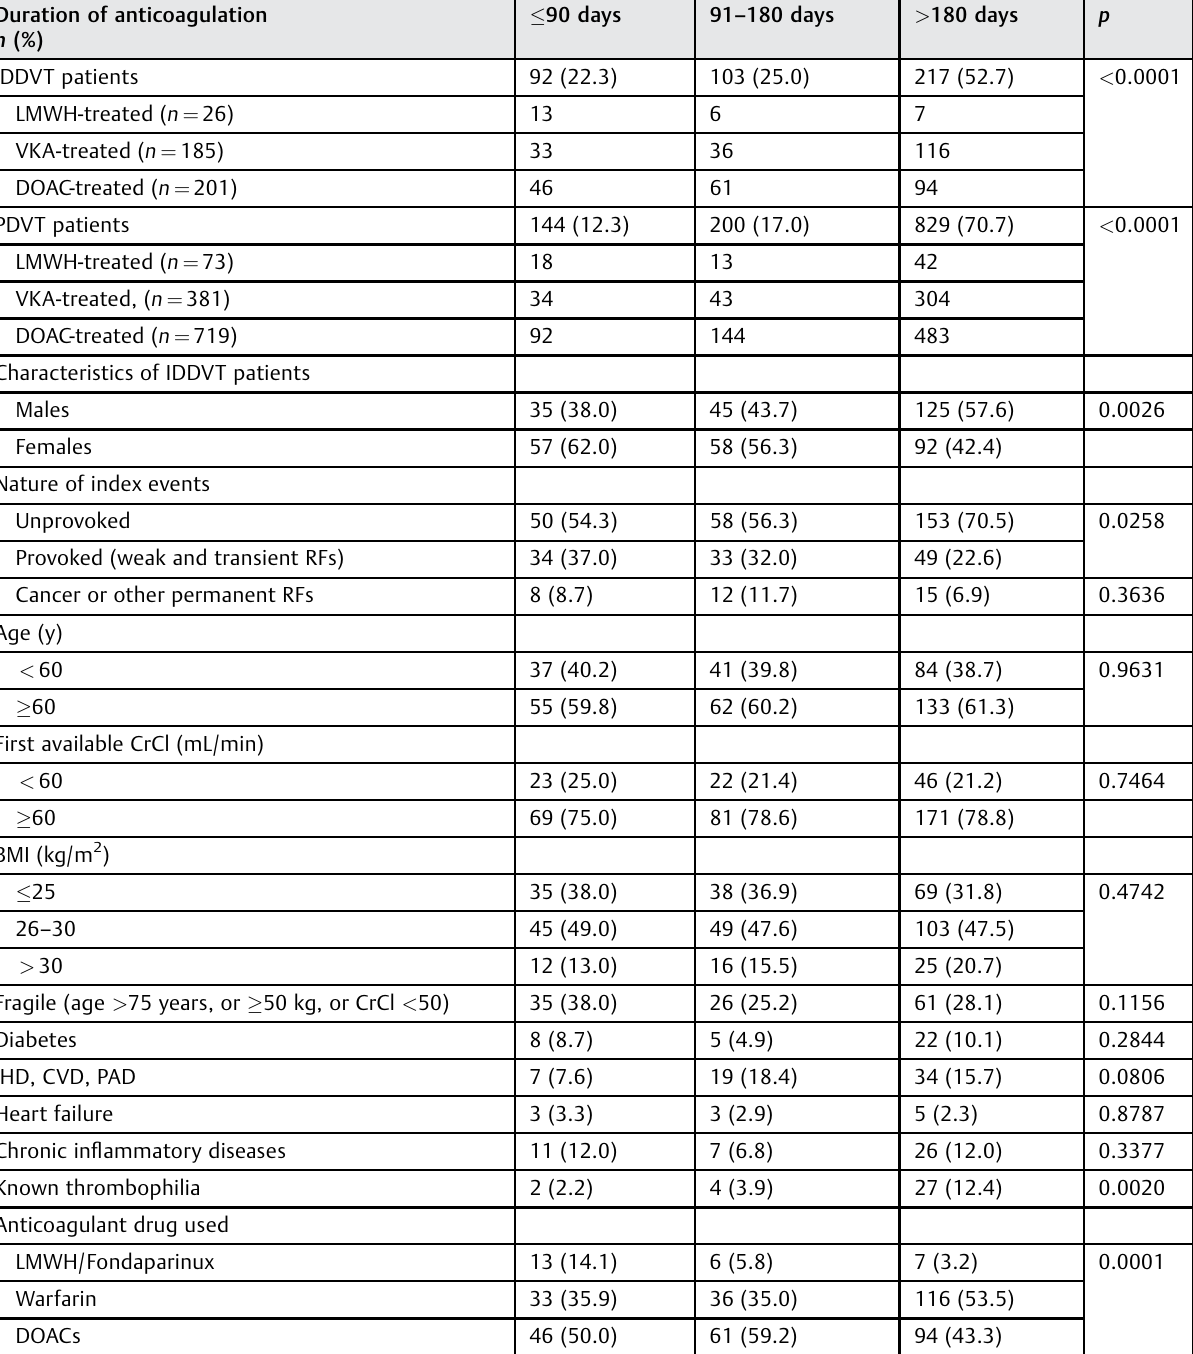
Table 2 Distribution of treatment duration in patients with IDDVT or PDVT in relation to the anticoagulant drug used and characteristics of IDDVT patients Duration of anticoagulation n